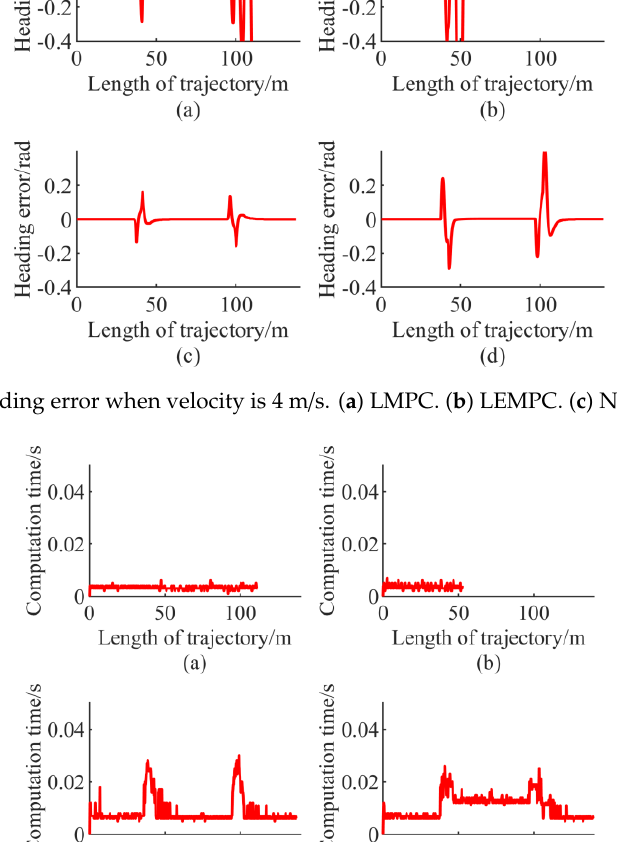
Figure 16. The displacement error when velocity is 4 m / s. ( a ) LMPC. ( b ) LEMPC. ( c ) NMPC. ( d ) NEMPC.